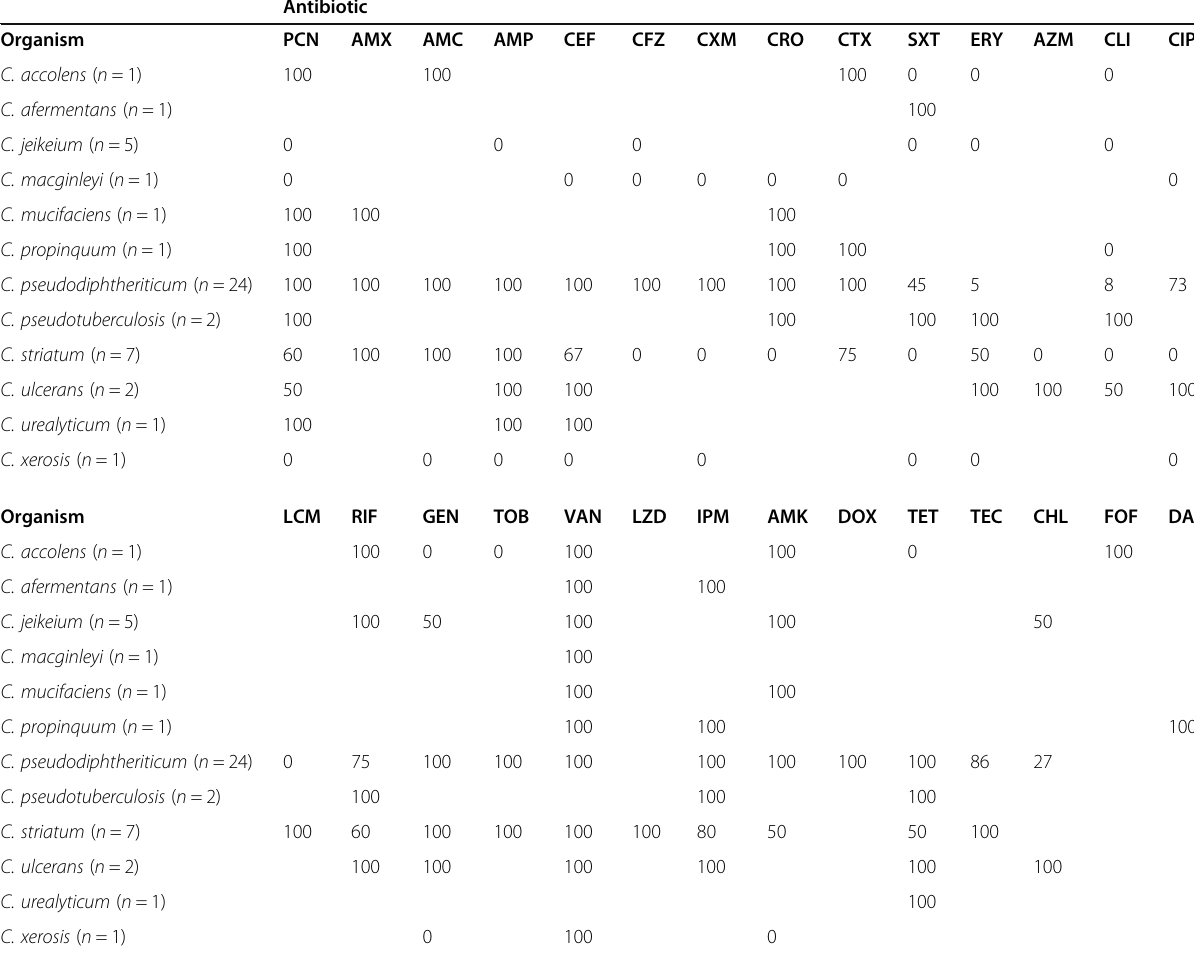
Table 3 Antibiotic susceptibilities of Corynebacterium spp. identified as causes of pulmonary